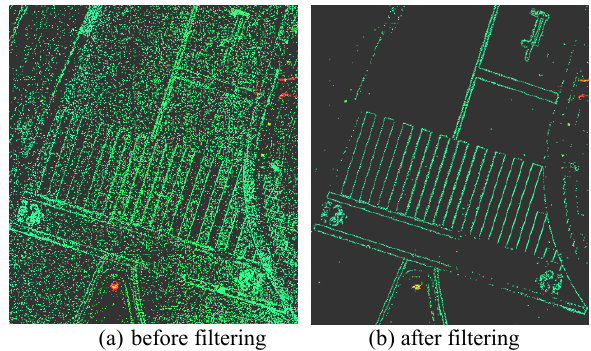
Figure 7. Noise reduction by median filtering